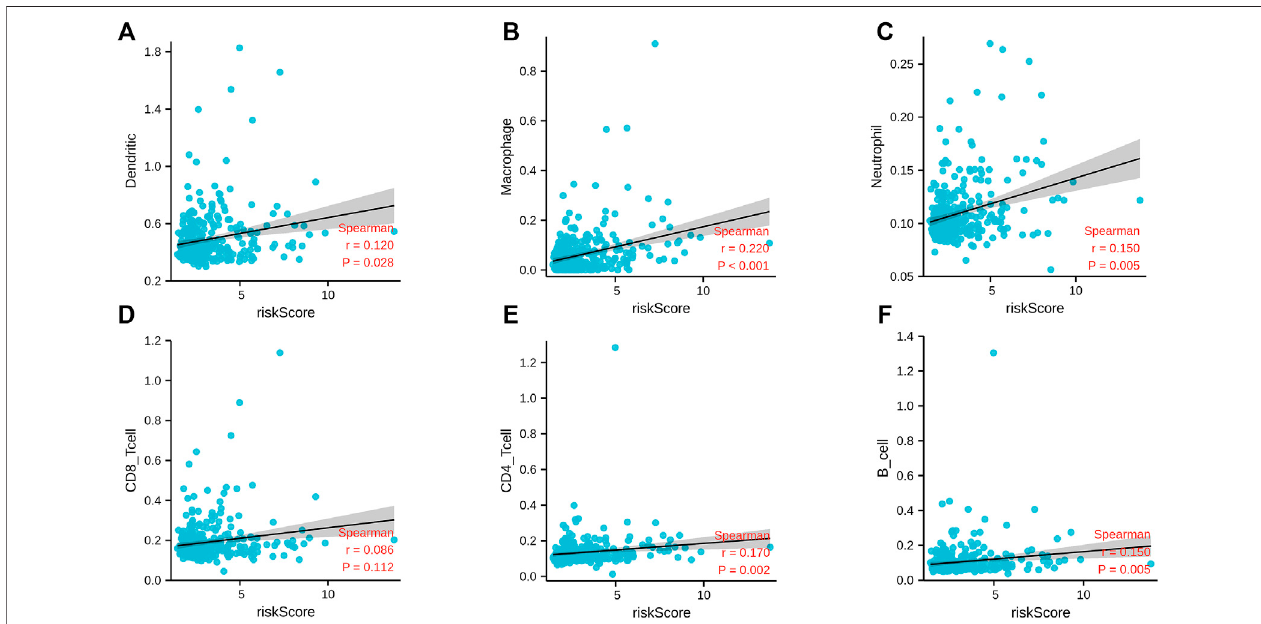
FIGURE 10 | Correlation analysis between m6A-correlated lncRNA risk score and immune cell in fi ltration. (A) Dendritic; (B) macrophage; (C) neutrophils; (D) CD8 T cells; (E) CD4 T cells; (F) B cells.